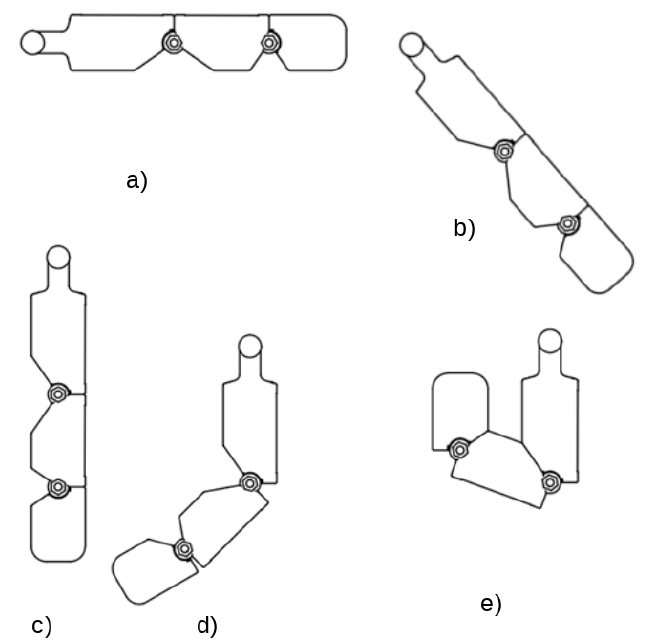
Figure 5. Coordinated flexion of the finger relative to the rotation axis of the hand in an extended position. ( a – c ) Flexion of the proximal phalange from a resting position. ( c , d ) Flexion of the middle and distal phalanges. ( d , e ) Completely flexed